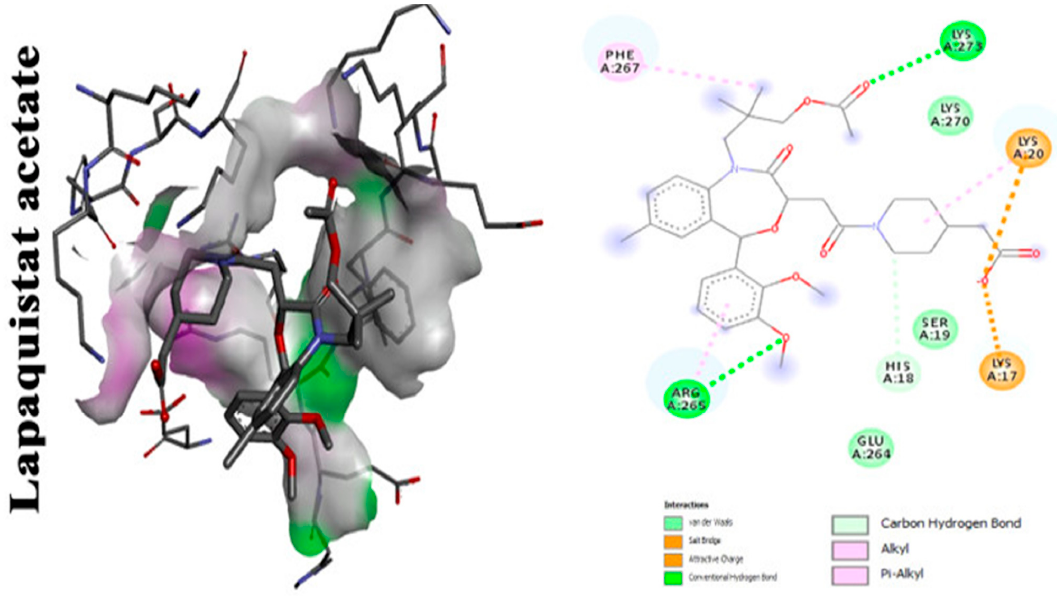
Figure 6. Molecular docking analysis showing 2D (on the right panel) and 3D (on the left panel) representation of interaction patterns of lapaquistat acetate with dehydrosqualene synthase receptor